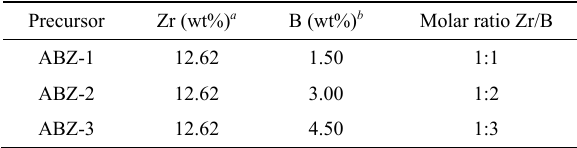
Table 1 Content of Zr and B in the feed for the synthesis of single-source